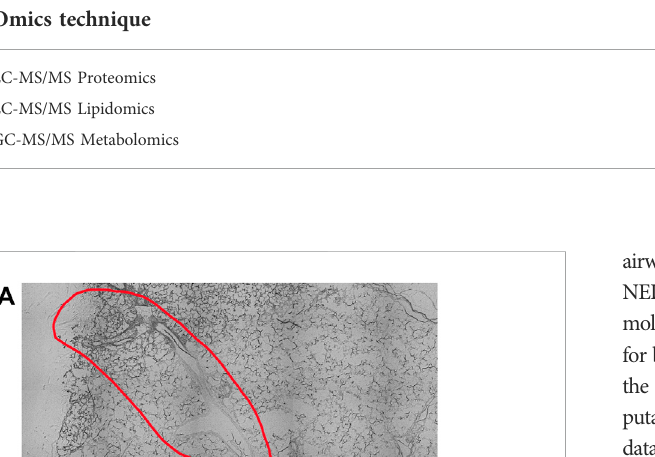
TABLE 1 Number of species identi fi ed from three samples from LC-MS/MS proteomics and lipidomics, and GC-MS/MS metabolomics from agarose in fl ated5% CMCembeddedhuman lung.Tables containingthe identi fi cationsofthe speciescanbefoundin thesupplemental information.Lipid species identi fi ed are from positive and negative ion mode combined.